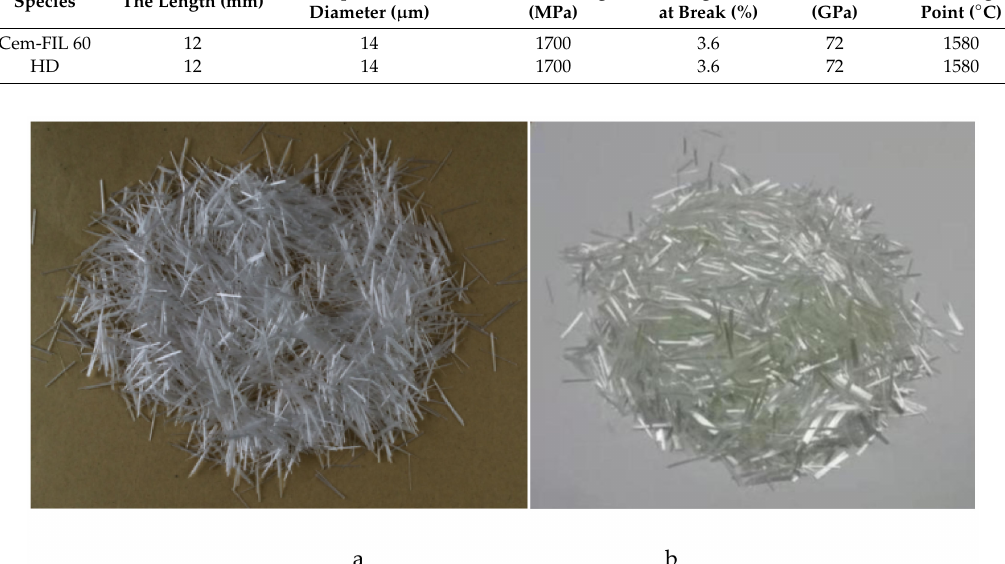
Figure 1. Two specimens of alkali-resistant glass fiber (ARGF): ( a ) Cem-FIL60 ARGF; ( b ) HD